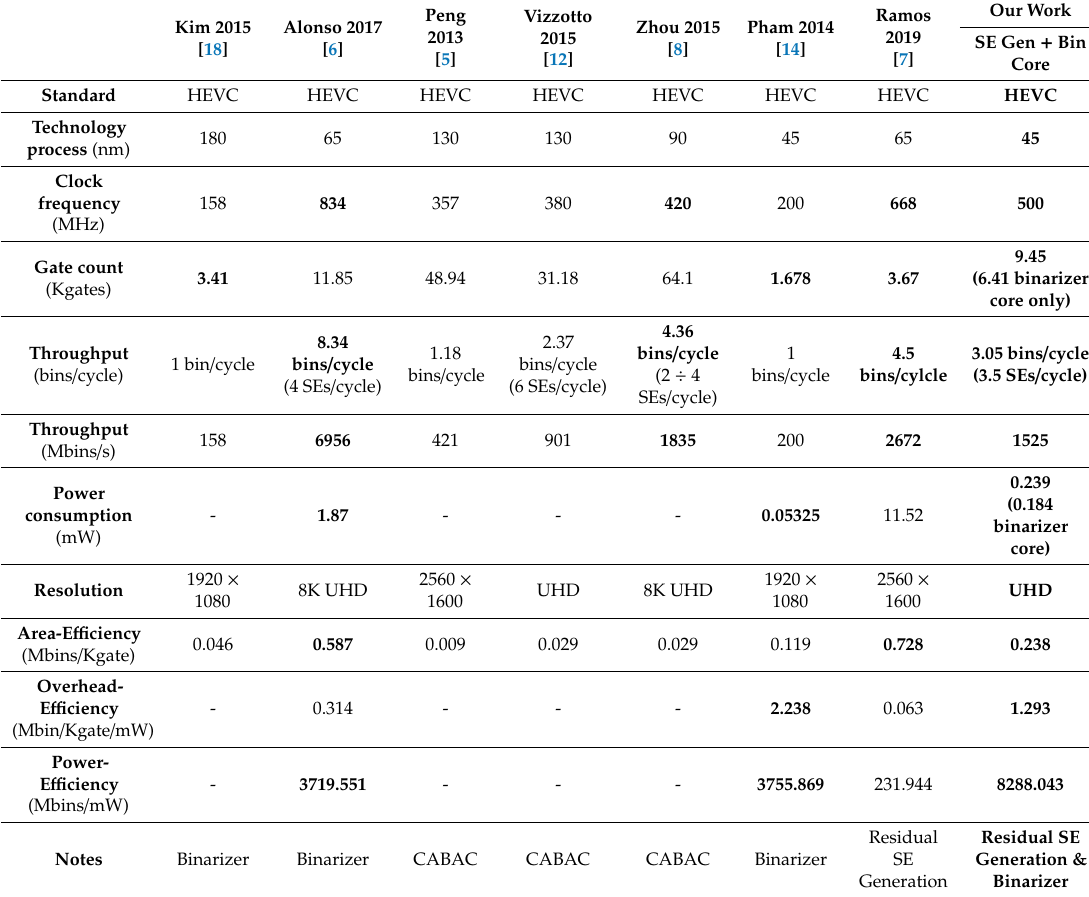
Table 3. Comparisons with related